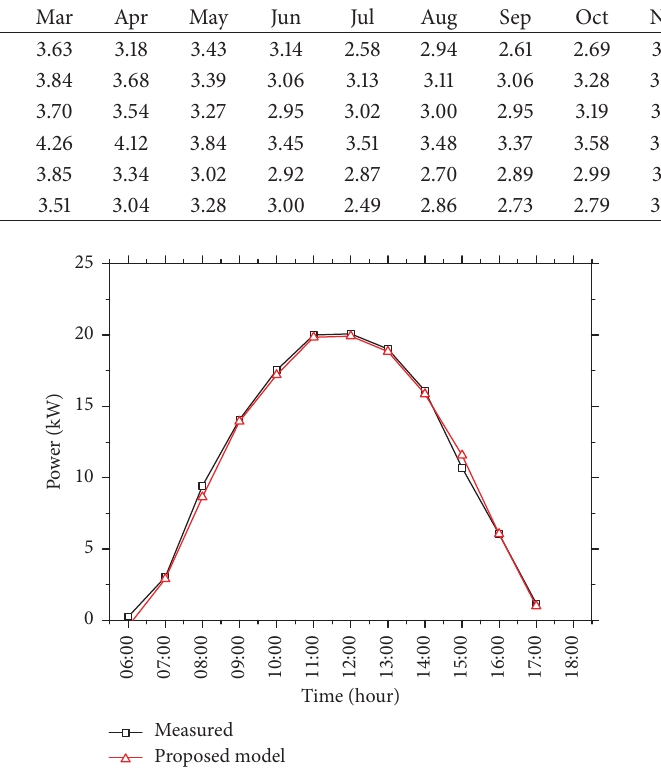
Figure 7: Prediction and measured PV power output on 15th Jan 2015 (sunny day).